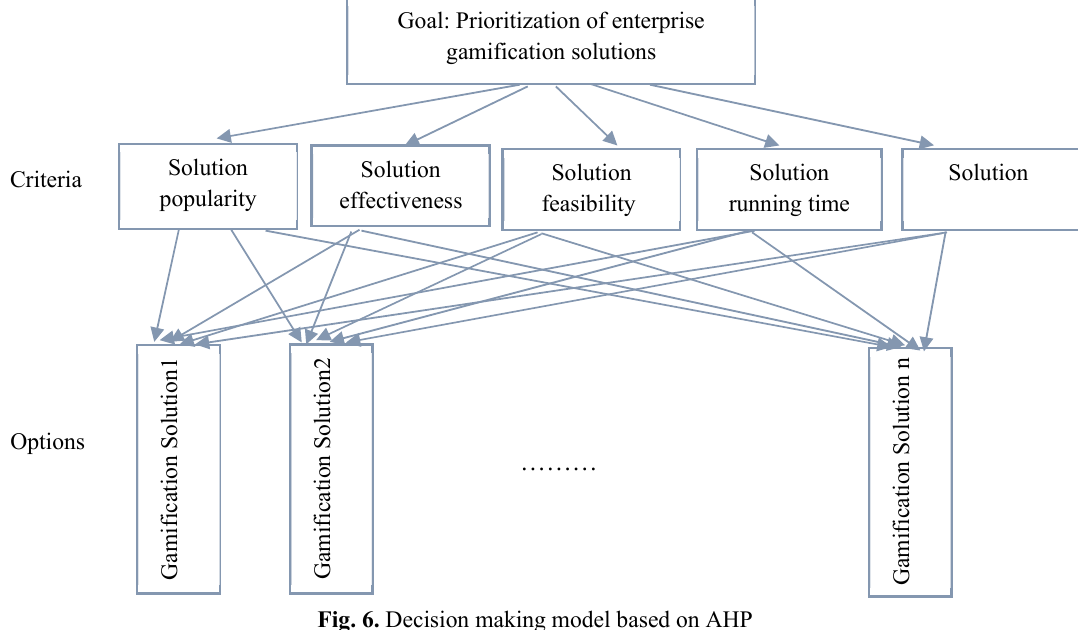
Fig. 6. Decision making model based on AHP